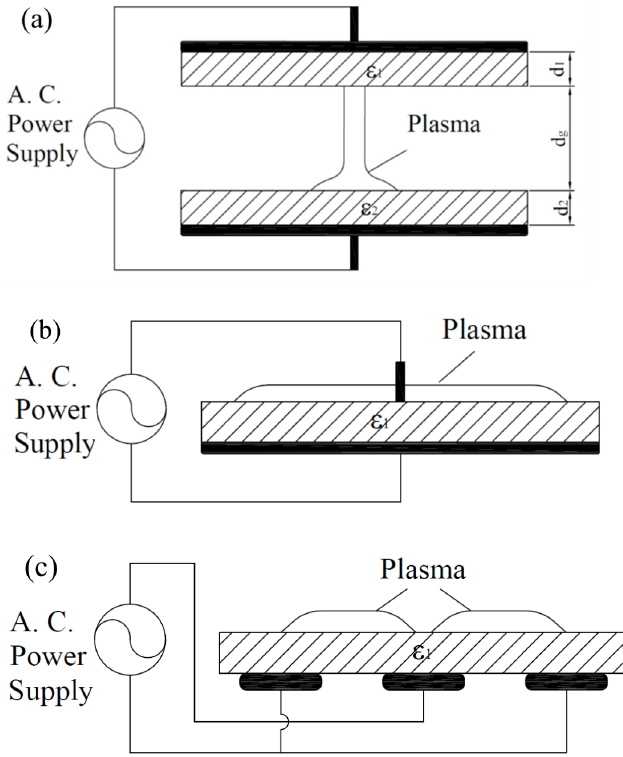
Figure 1. Three configurations of DBD: ( a ) VBD; ( b ) SBD; and ( c ) CBD.